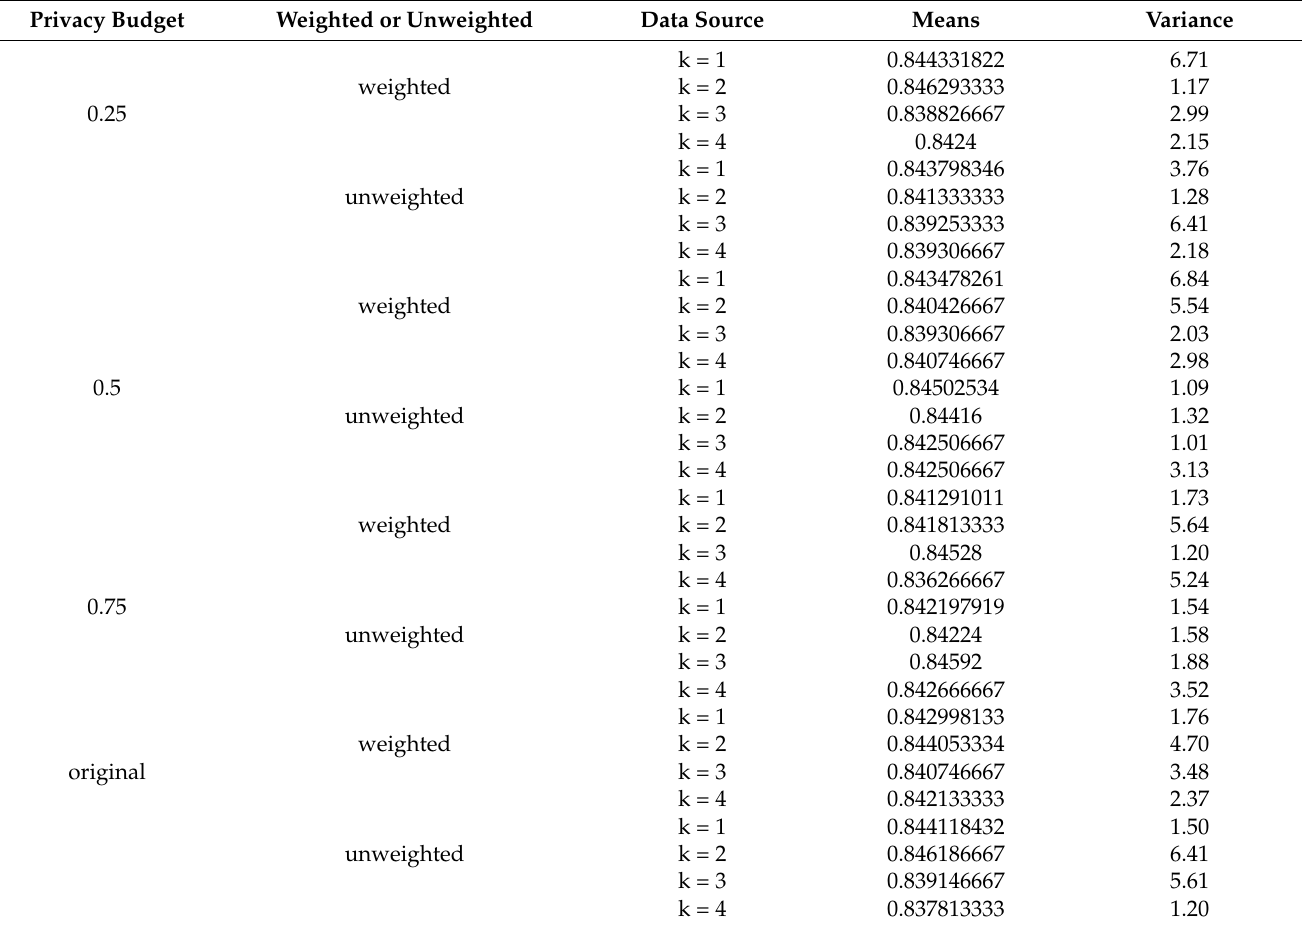
Table 9. The stacking ensemble performance of the initial global model H 3 for the t 4